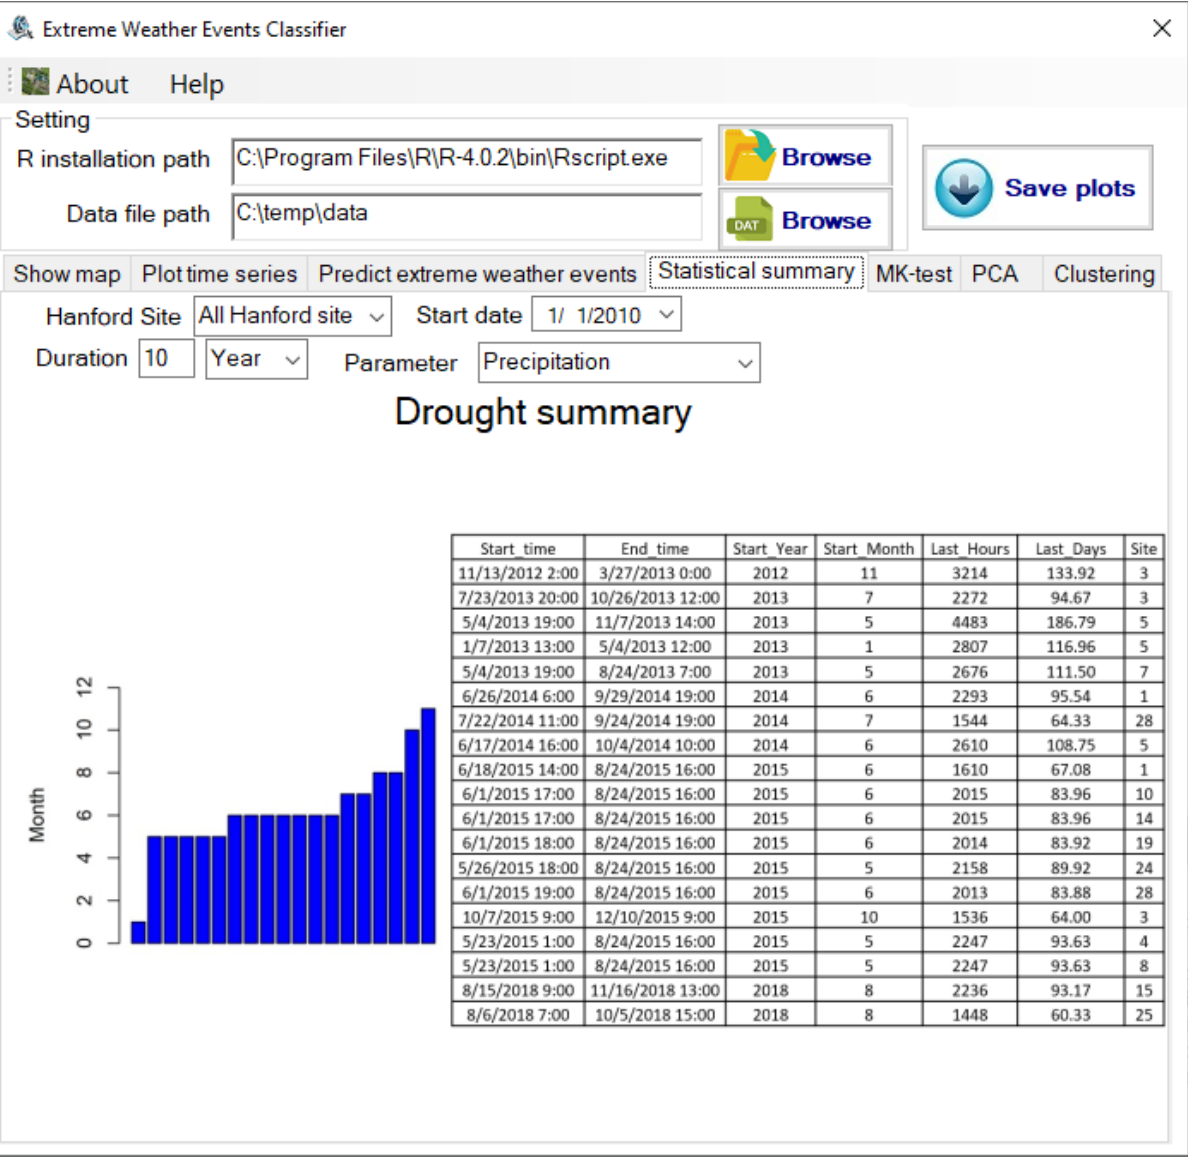
Figure 7. Drought summary based on precipitation data of all Hanford sites from 2010 to 2019.